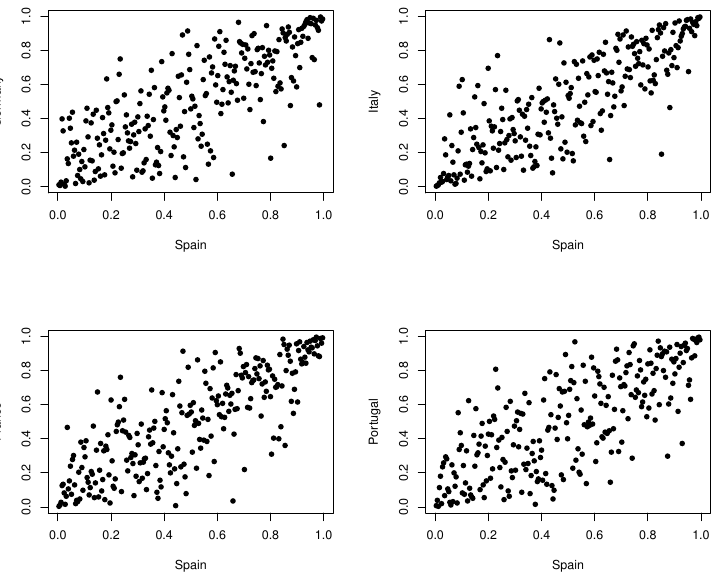
Figure 3. Pseudo-data for each bivariate copula between Spain and Germany, Italy, France and Portugal.